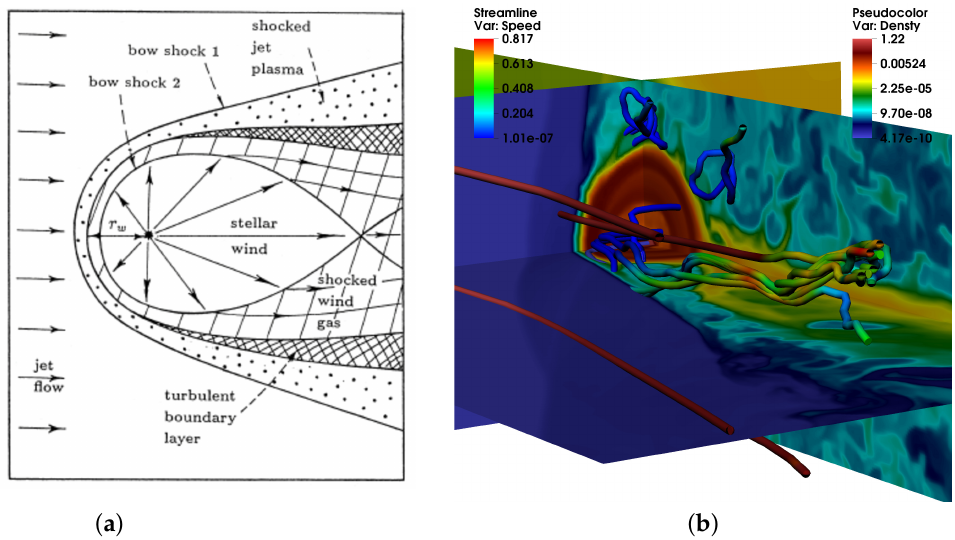
Figure 7. ( a ) Schematic plot of jet-stellar wind interaction [42]. ( b ) Rest-mass density distribution from a 3D RHD simulation of a star/wind bubble system entering into a jet [152]. The image shows three cuts across the grid, displaying the position of the wind injector (star). The color scales indicate the speed (top left) and the rest-mass density (top right). The star enters the jet from the right to the left, which is occupied by the jet flow. The jet flow appears in blue color, with a velocity directed towards the bottom of the image. The current lines show, on the one hand, the deviation and deceleration of the jet flow as it crosses the bow-shock, and, on the other, the shocked wind material being dragged downstream and forming an unstable